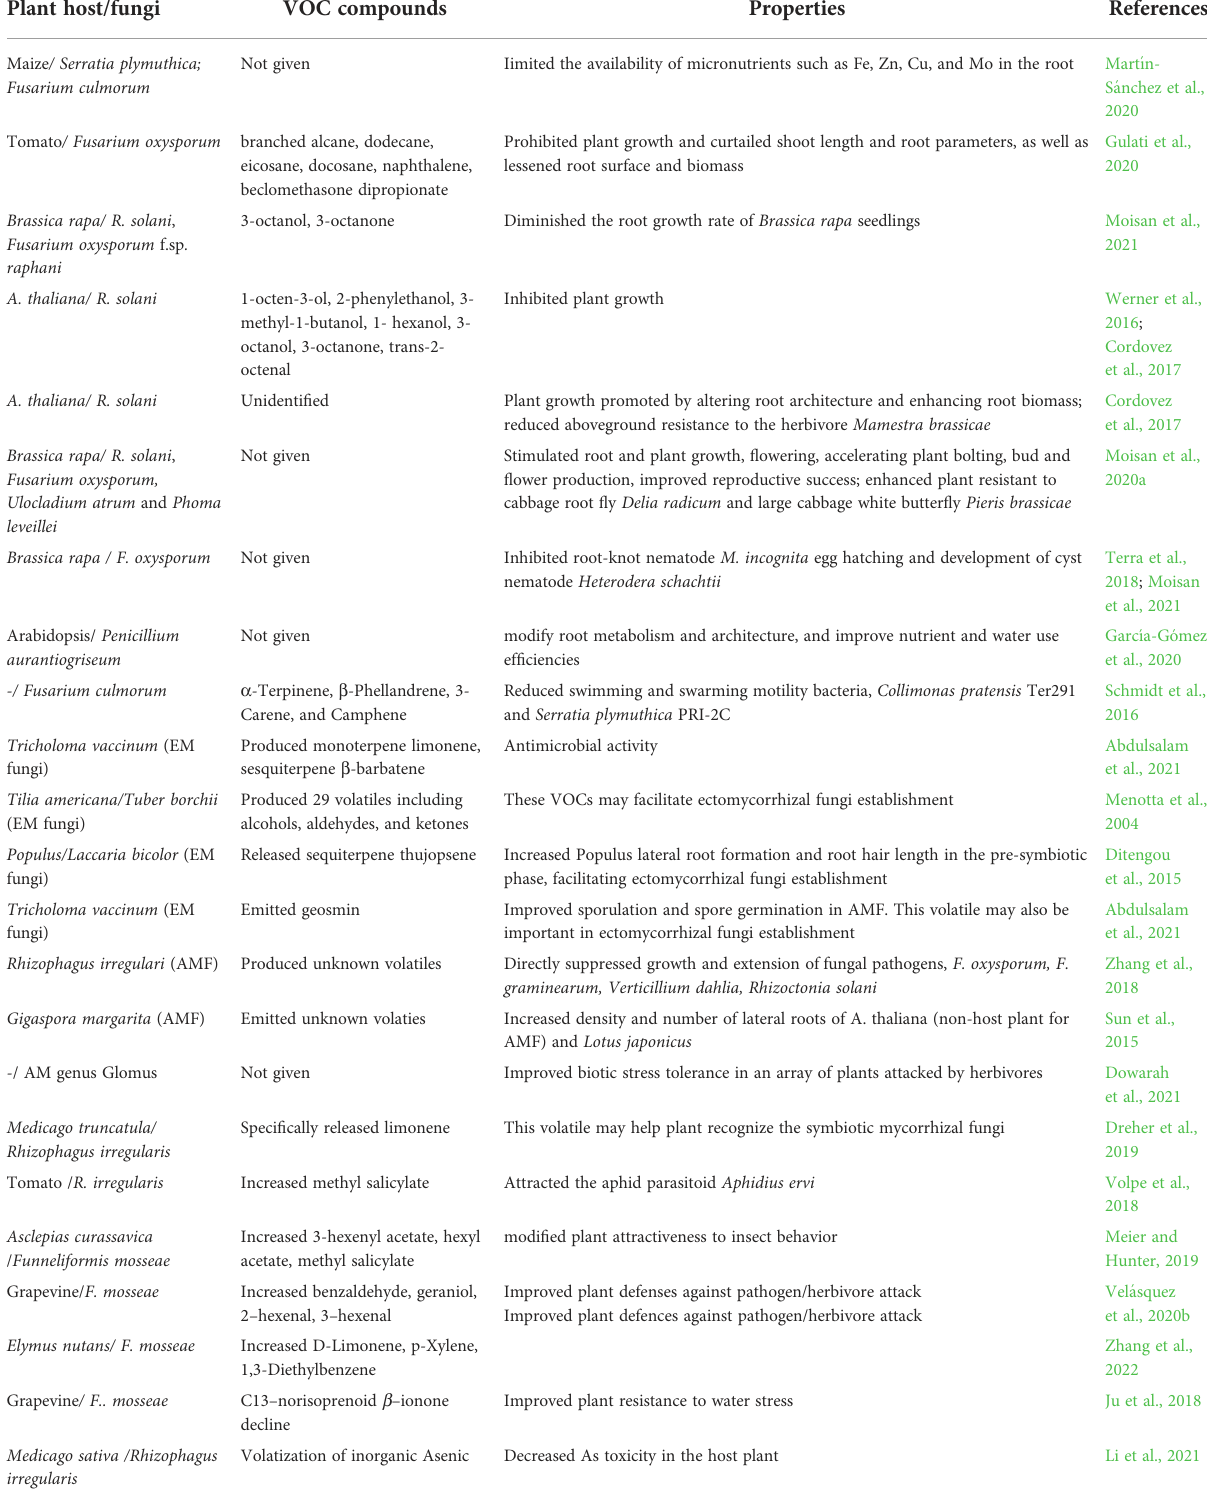
TABLE 2 Fungal VOCs and its effect to plant